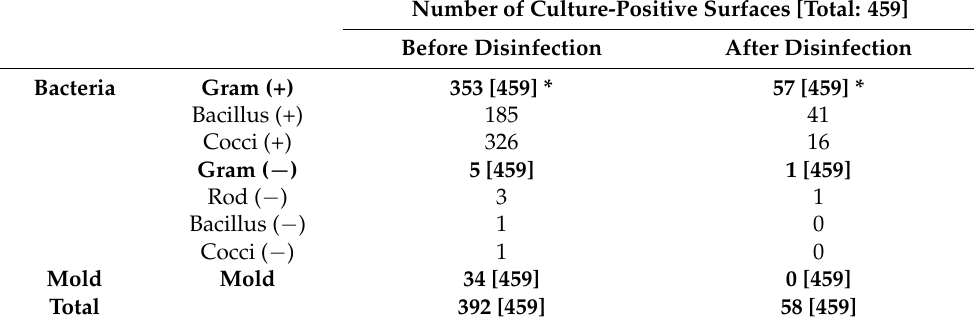
Table 1. Surfaces positive for bacteria and mold before and after disinfection with plasma-treated hydrogen peroxide mist disinfectant. Number of Culture-Positive Surfaces [Total: 459] Before Disinfection After Disinfection Bacteria Gram